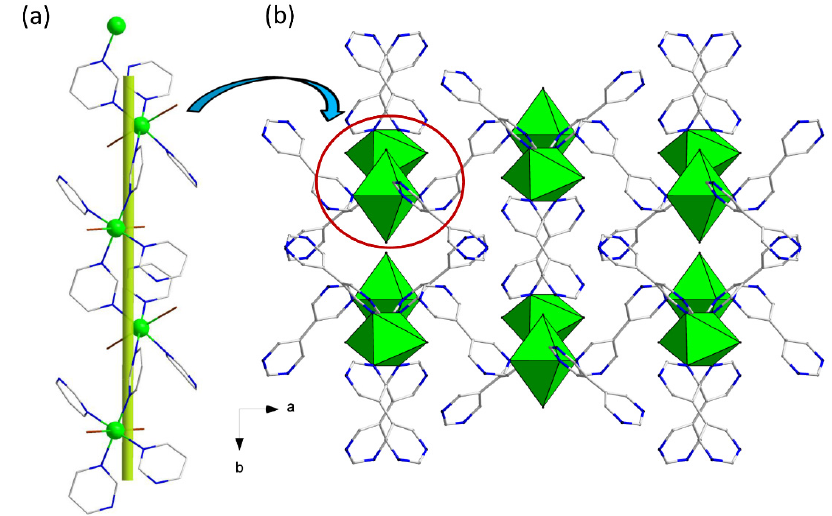
Figure 2. ( a ) The perspective view of the Ni–pyrimidyl screw chain aligned along the [001] direction in 1 ; ( b ) view of the 3D framework of compound 1 along the c axis.